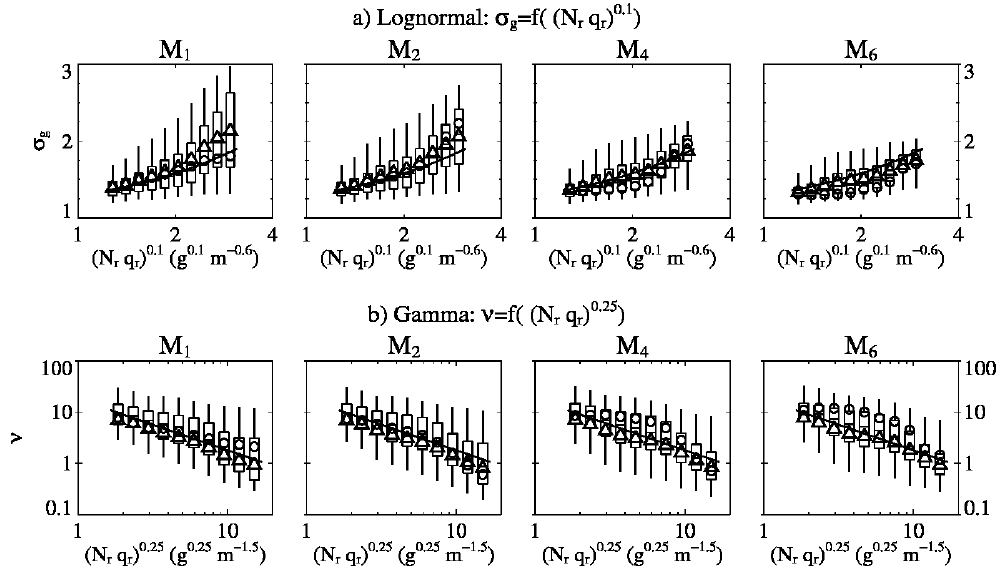
Figure 6. Same as Fig. 4 but plotted as a function of a power law of q r N r . The thick lines represent the proposed parameterizations for the variable shape